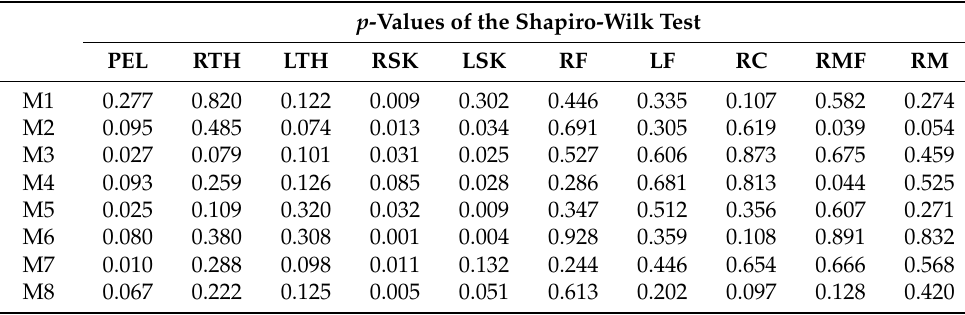
Table 2. Achieved Results of Testing Normality of Data Using Shapiro-Wilk Test. p -Values of the Shapiro-Wilk